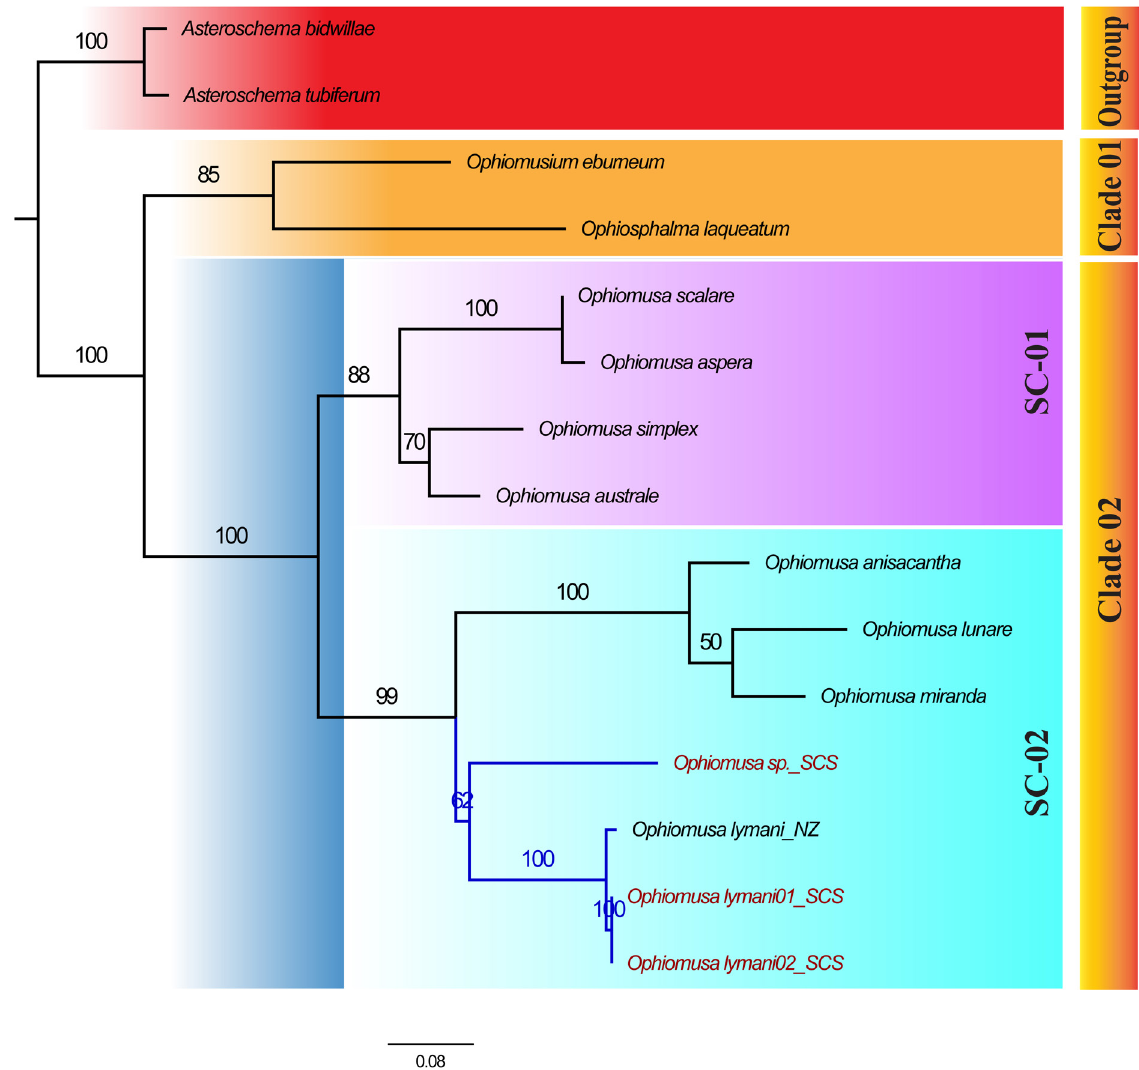
Fig. 45. Family Ophiomusaidae O’Hara et al. , 2018, Maximum likelihood (ML) tree based on partial COI sequences (bootstrap support values were generated with rapid bootstrapping algorithm for 1000 replicates). Abbreviations: NZ = New Zealand; SC = Sub-Clade; SCS = South China